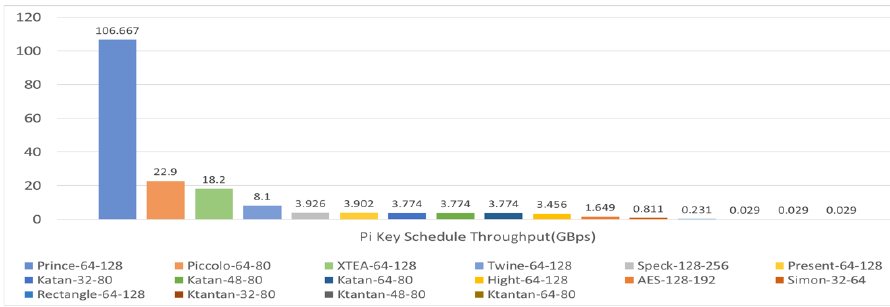
Figure 10. The 10 largest speed throughput in key schedule and 5 least in